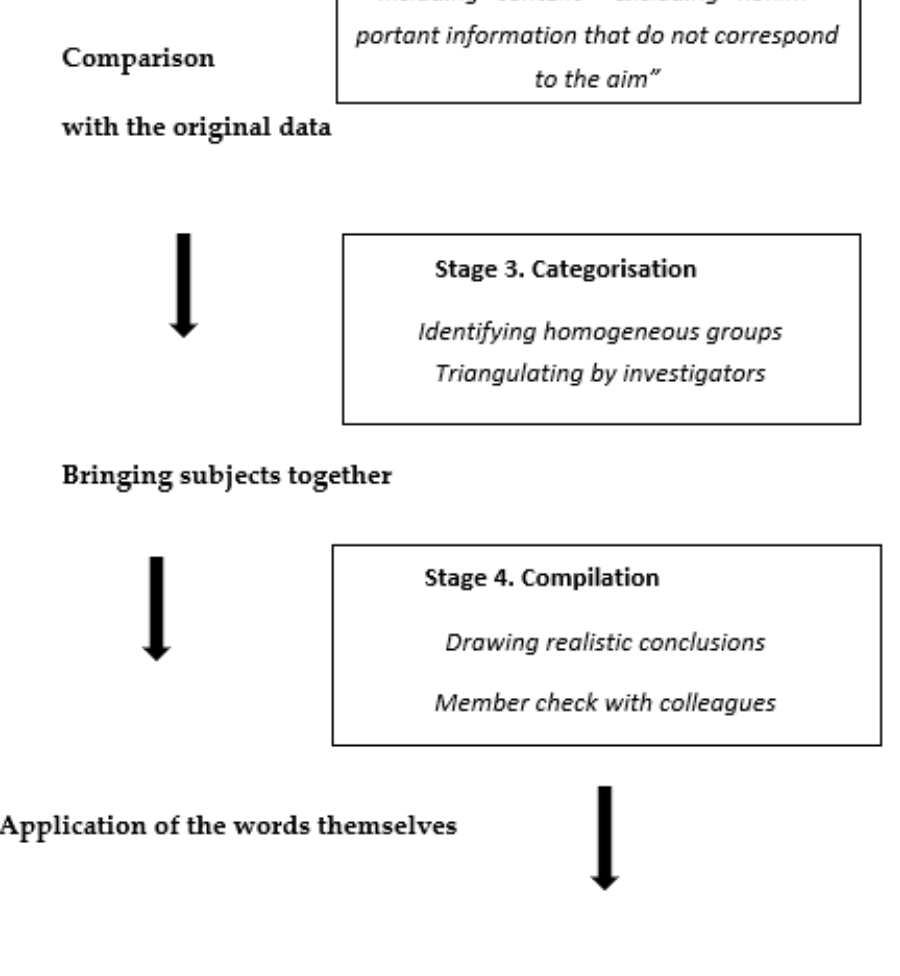
Figure 1. The process of qualitative content analysis (adapted from Bengtsson [ 41]).